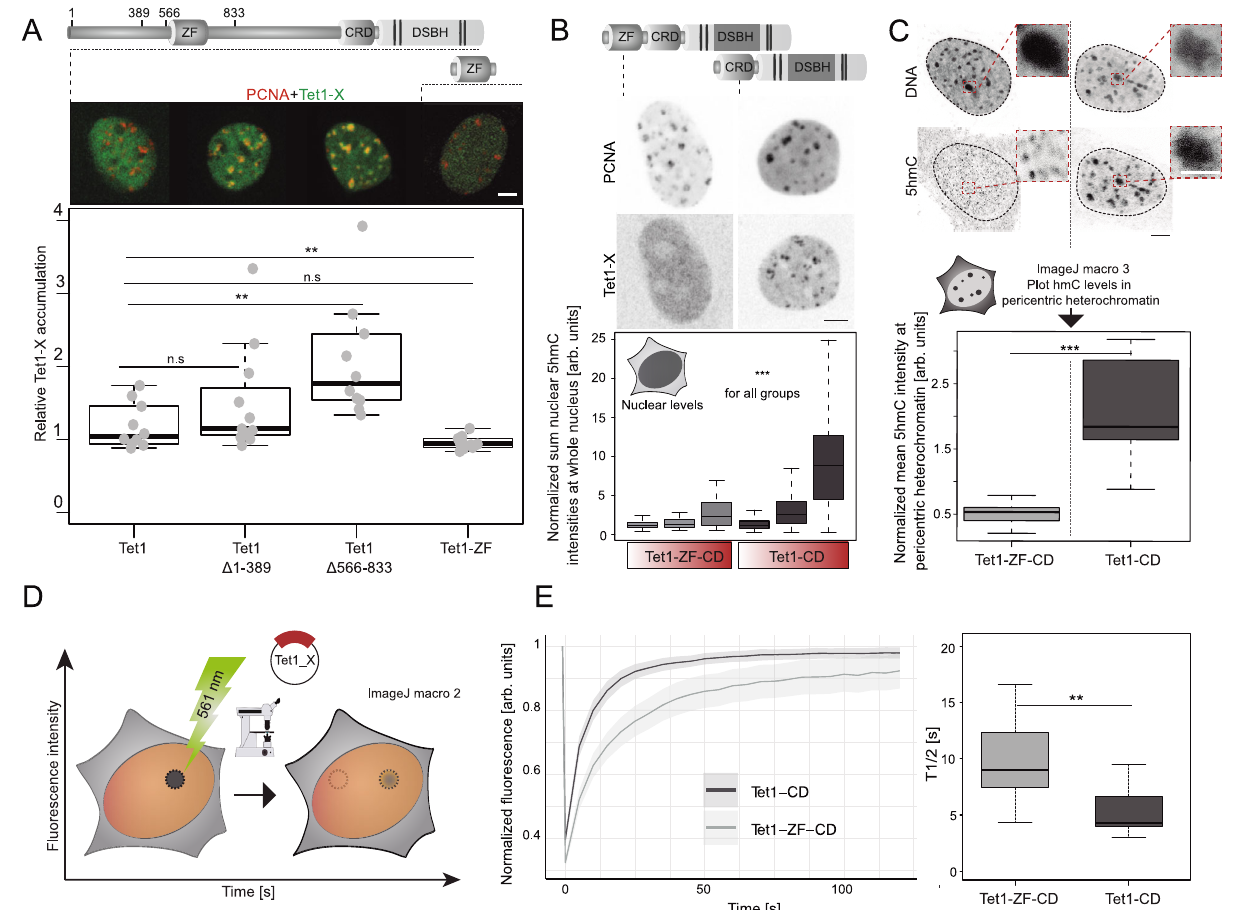
Fig. 4 | The zinc fi nger domain of Tet1 impedes S-phase dependent hetero- chromatin association and prevents aberrant 5mC oxidation. A Domain orga- nizationof Tet1 with locations of amino acids corresponding to N-terminaldeletion mutants. Representative images of C2C12 cells in late S-phase expressing EGFP- tagged Tet1/Tet1 Δ 1-389/Tet1 Δ 566 − 833/Tet1-ZF domain and mRFP-PCNA. Boxplot shows quanti fi cation of relative accumulation. B C2C12 cells were transfected with mcherry-Tet1CD/Tet1-CD-ZF and EGFP-PCNA. Representative images of cells in late S-phase are shown. In situ 5hmC levels were analyzed 24h after transfection by wide- fi eld high-content microscopy. Boxplots show sum nuclear 5hmC levels nor- malized by averaged levels in non-transfected cells and sum nuclear DAPI. Cells were grouped by their mean mcherry fl uorescence intensities into low, mid, and high expressing (see Supplementary Fig. 2B, C). C Representative images of C2C12 from 4B. Selected ROIs in pericentric heterochromatic regions weremagni fi ed. Fiji- based in situ 5hmC quanti fi cation was performed and results are shown in boxplot (5hmC levels in pericentric heterochromatin in dark-gray). D FRAP experiments